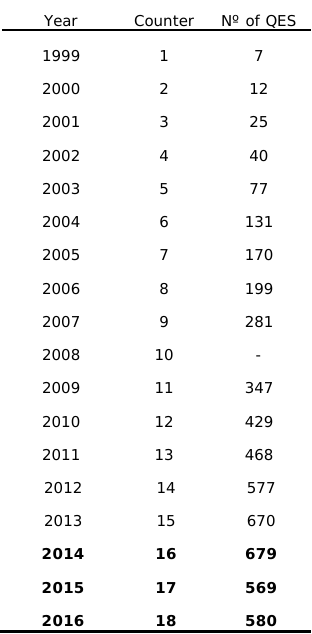
Table 2. Data used to fit the